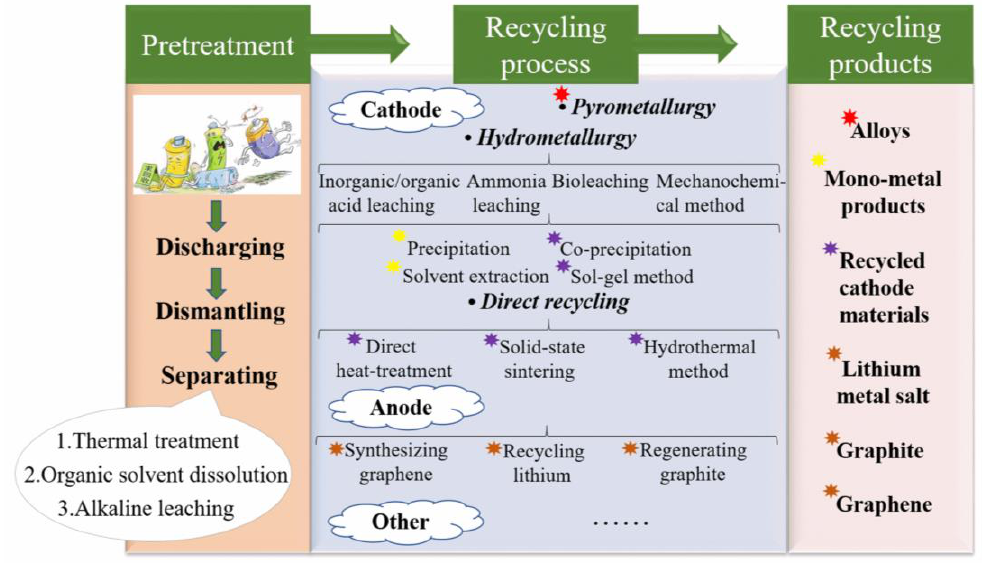
Figure 3. Comparison of different LIBs recovery methods.